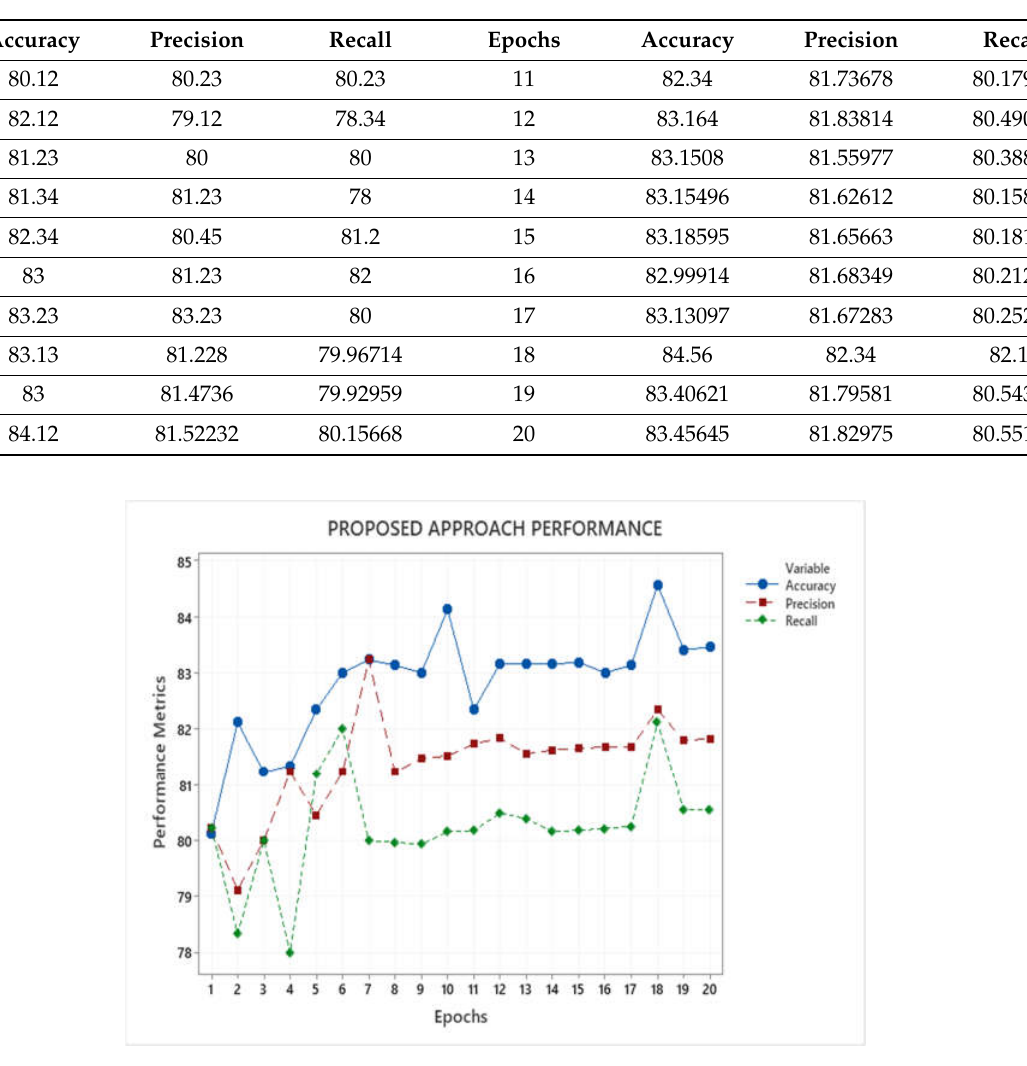
Table 5. Epoch tuning.